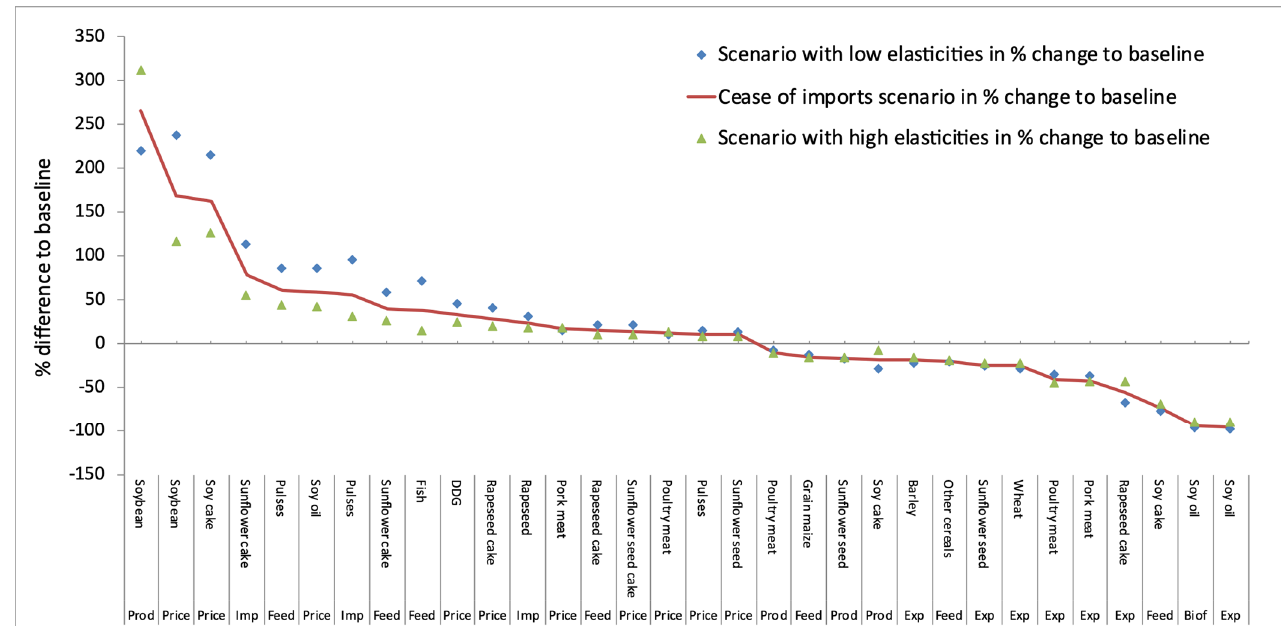
Figure 6. Sensitivity analyses for high and low supply elasticities presented for the market balance positions and the market prices in the EU. We present products and positions with an absolute difference higher than 0.5 million tones and more than 15% compared to the baseline. The red line represents the cease of import scenario, the blue and the green dots the low and high elasticity scenario.